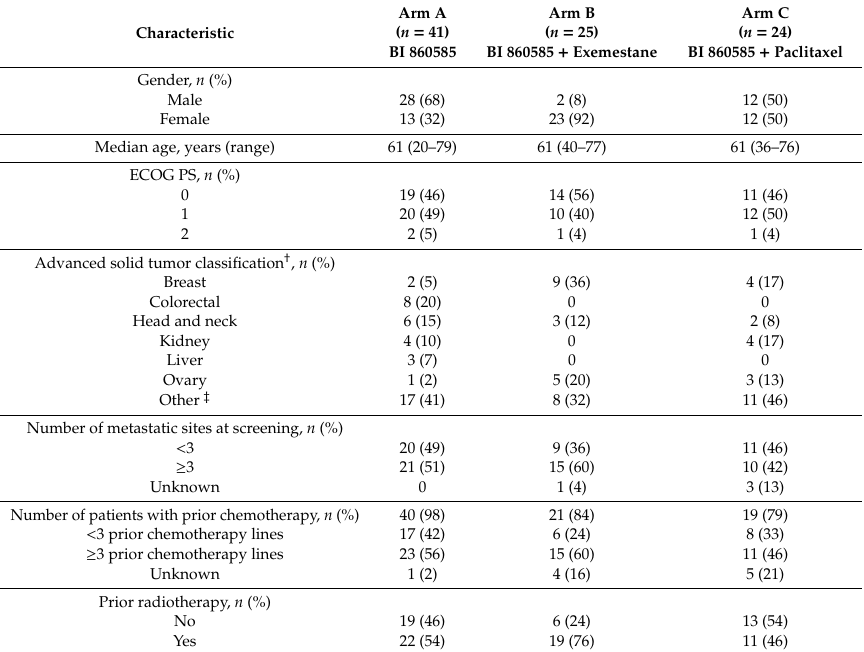
Table 1. Baseline